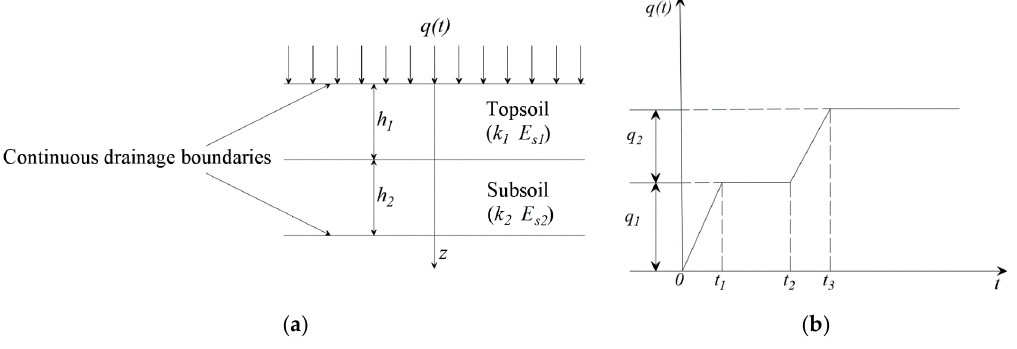
Figure 1. Schematic diagram: ( a ) Double-layer soil foundation calculation model, and ( b ) the curve of loading.